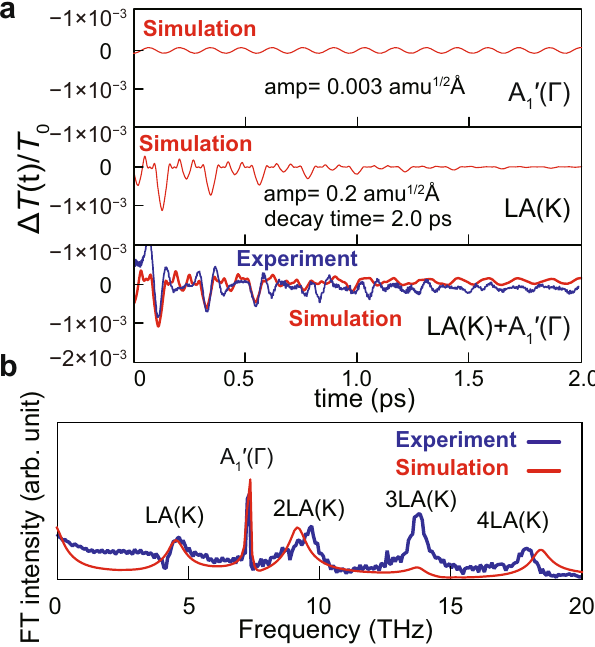
Fig.4|Simulatedandexperimentaldifferentialtransmittance Δ T ( t )/ T 0 andCP spectra. a Simulated differential transmittance Δ T ( t )/ T 0 of the A 1 ′ ( Γ ) mode (upper panel),LA(K)mode(middle panel) and combination of the LA(K)and A 1 ′ ( Γ ) modes (bottom panel). Simulation parameters are shown in the insets. b Comparison of experimental and simulated CP spectra. The latter was obtained from the Fourier transformation of the differential transmittance Δ T ( t )/ T 0 of the combination of LA(K) and A 1 ′ ( Γ ) modes (bottom panel of a ).